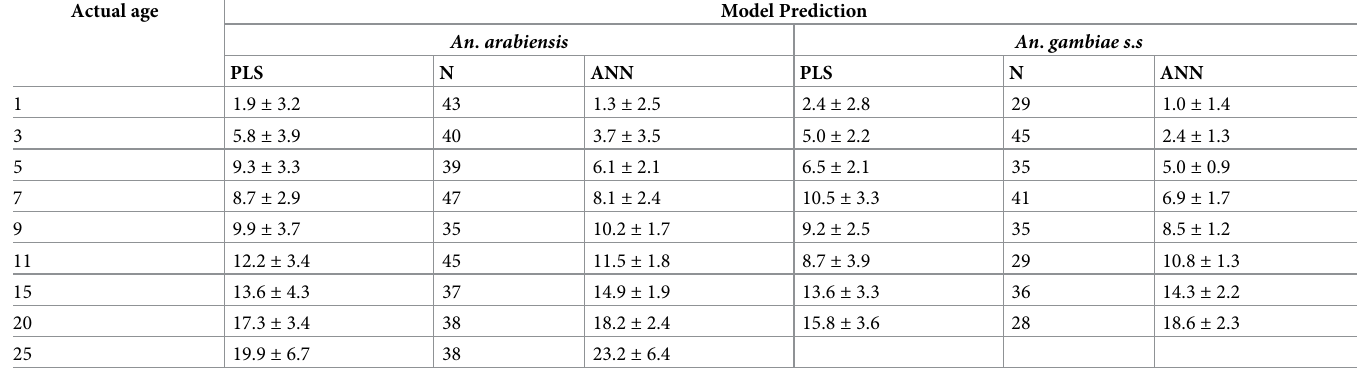
Table 2. Mean actual age estimation of mosquitoes in out of the sample test sets by ANN and PLS regression models. Column “N” represents the number of mosqui- toes in each age group. Actual age Model